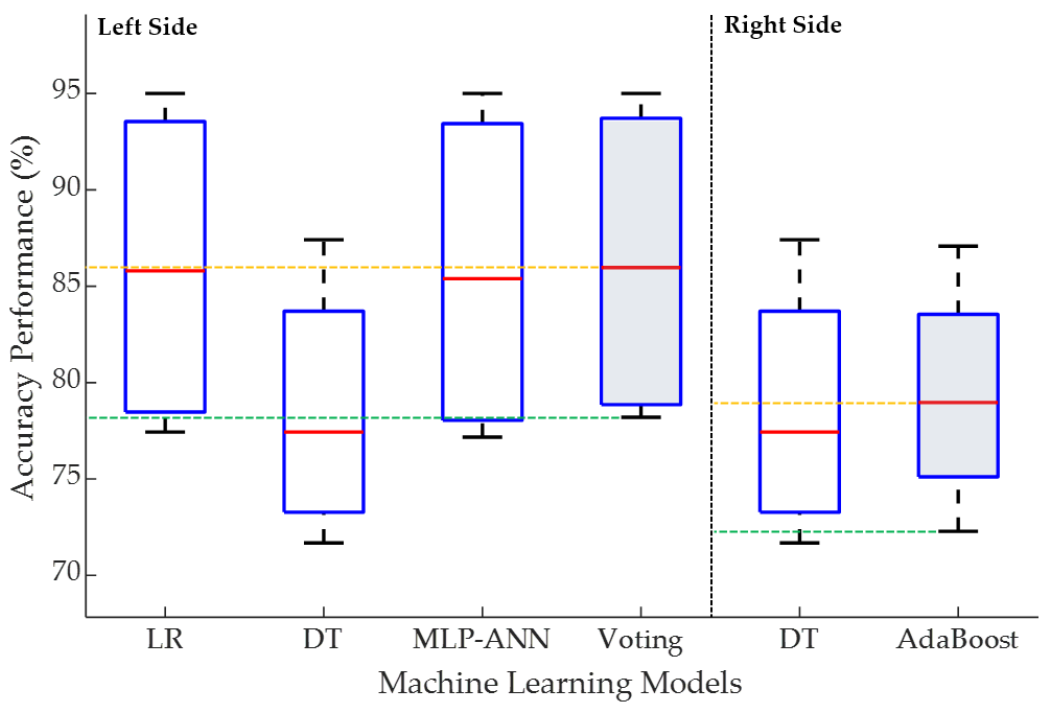
Figure 7. Classifier-level overall accuracy performance comparison, ( Left Side ): heterogeneous parallel ensemble learner vs. respective diverse base-learners, ( Right Side ): homogeneous sequential ensemble learner vs. respective single base-learner (shaded boxes represent the ensemble learners).